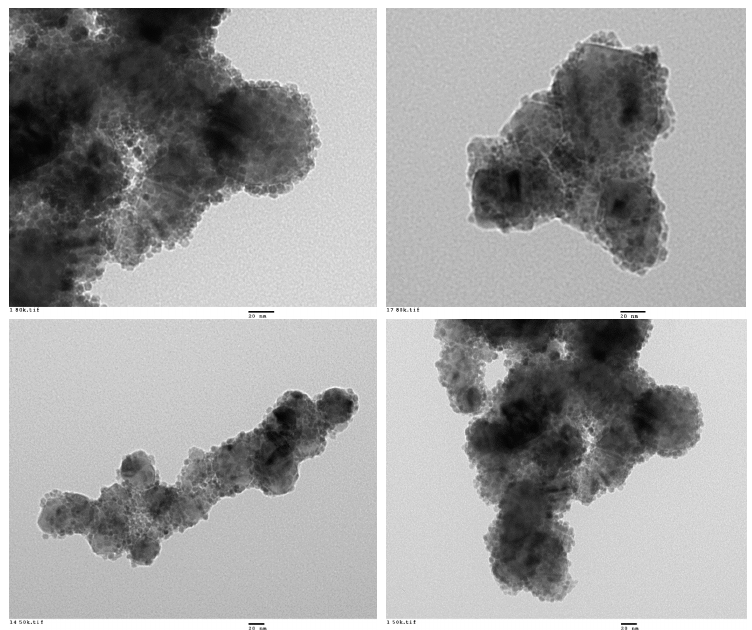
Figure 3. Representative HR-TEM images of the Fe 3 O 4 @SiC core–shell nanoparticles (lab synthesis).